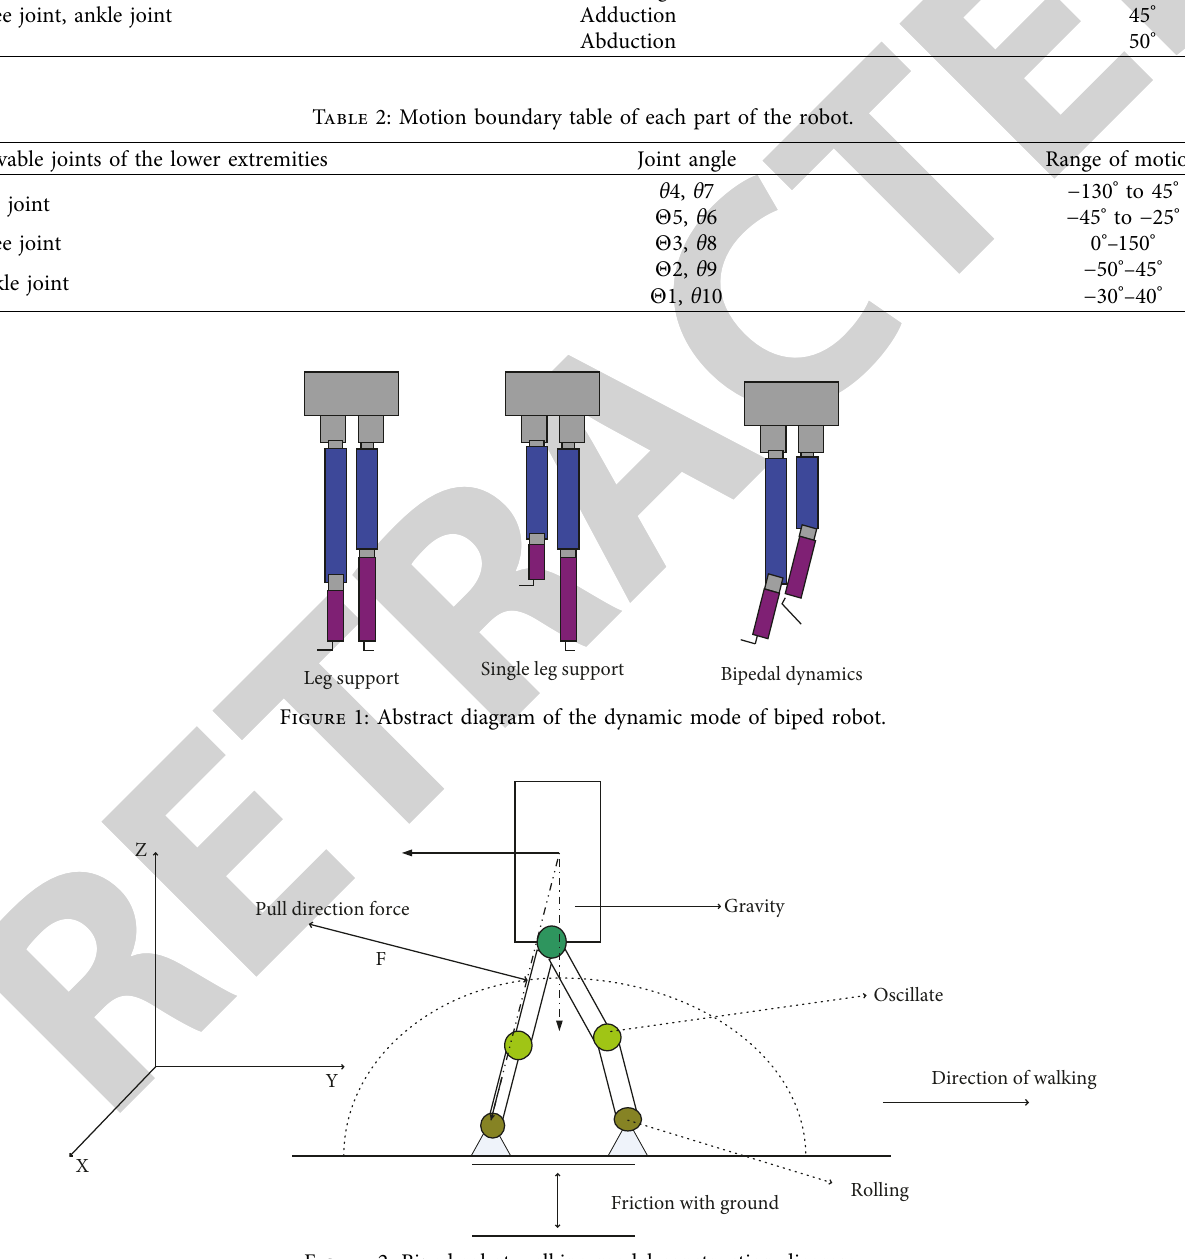
Figure 2: Biped robot walking model construction diagram.